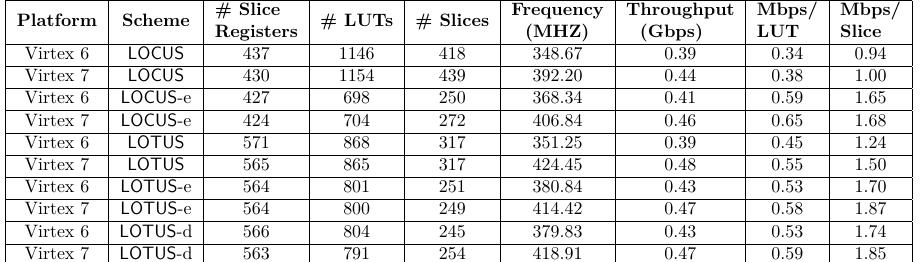
Table 5: LOCUS and LOTUS (combined enc/dec circuit) Implemented FPGA